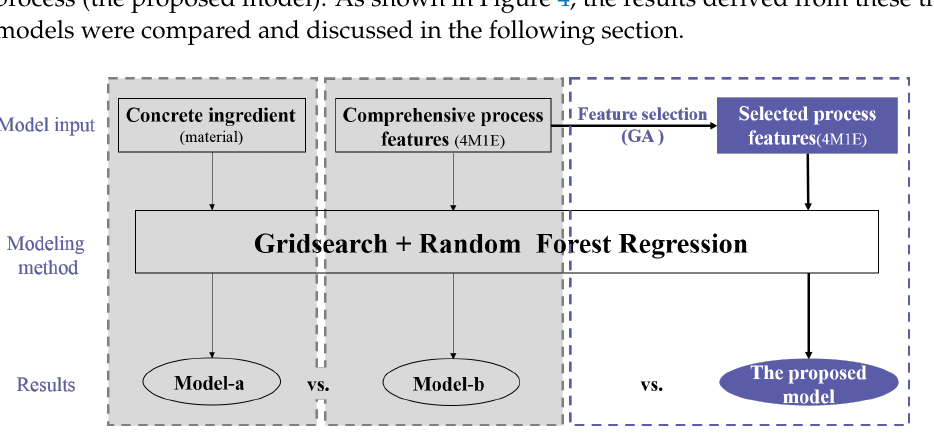
Figure 4. Framework of results